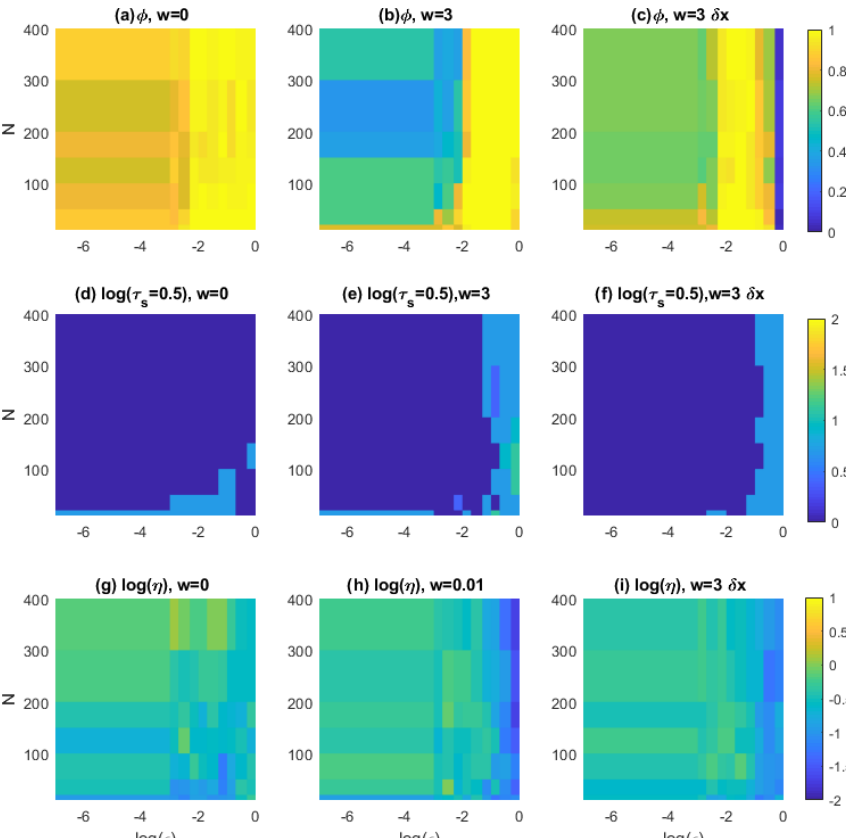
Figure 4. Analysis of the Pomeau–Manneville system for increasing noise intensity (cid:15) ( x axes) and number of neurons N ( y axes). The colour scale represents φ the rate of failure of the χ 2 test (size α = 0 . 05) (a–c) ; the logarithm of the predictability horizon log (τ s = 0 . 5 ) (d–f) ; the logarithm of initial error log (η) (g–i) . These diagnostics have been computed on the observable u(t) ≡ x(t) . All the values are averages over 30 realizations. Panels (a) , (d) , and (g) refer to results without moving averages, (b) , (c) , (e) , (f) , (h) , and (i) with averaging window w = 3, (c) , (f) , and (i) . Panels (b) , (e) , and (h) are obtained using the exact expression in Eq. (12) and (c) , (f) , and (i) using the residuals δ x in Eq. (10). The trajectories are all obtained after training the ESN for 10 5 time steps. Each trajectory consists of 10 4 time